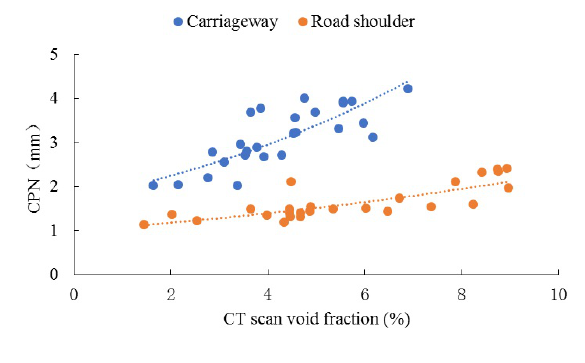
Fig. 7 Relationship between CT scan void fraction and CPN rutting